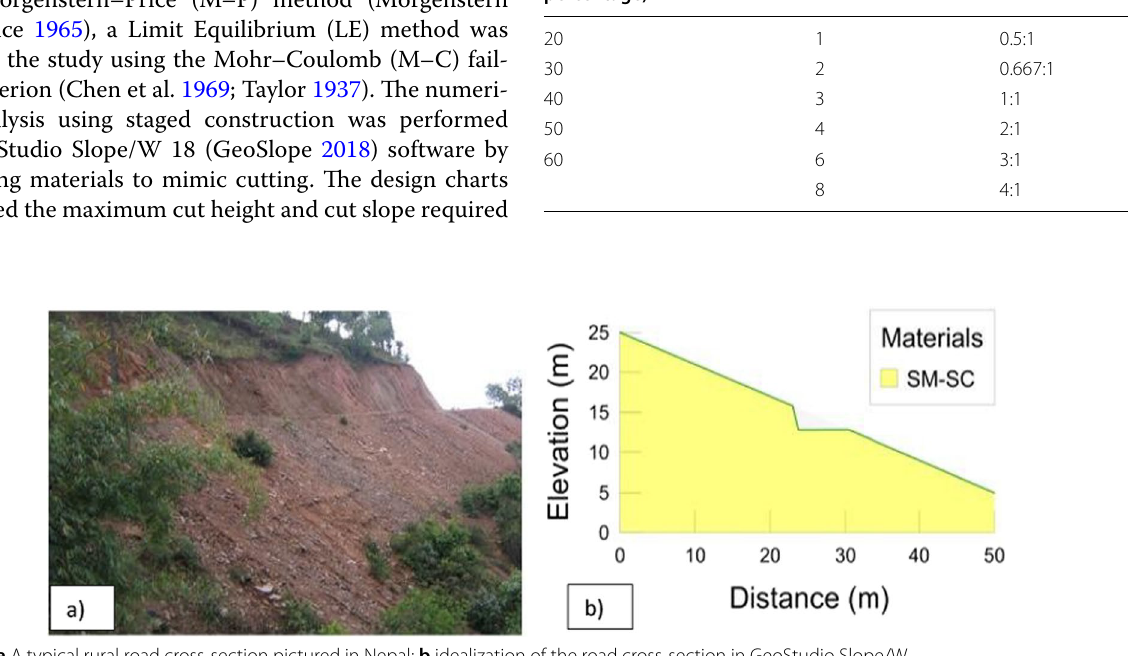
Fig. 3 a A typical rural road cross-section pictured in Nepal; b idealization of the road cross-section in GeoStudio